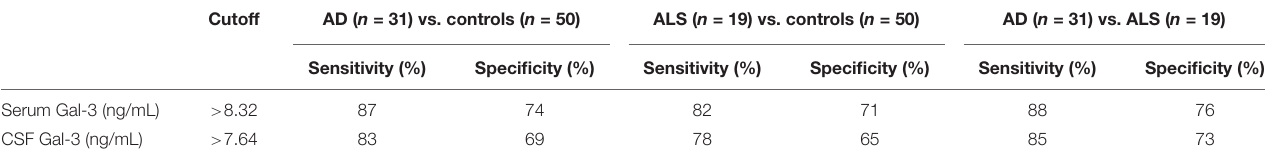
TABLE 3 | Cutoff scores, sensitivity and specificity values of serum and CSF Gal-3 concentrations differentiating the AD patients from controls, ALS patients from controls, and AD patients and ALS patients.